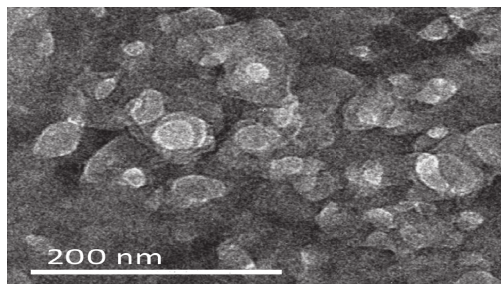
Figure 4: Scanning micrographs of chitosan nanoparticles synthesized using ionic-gelation method.